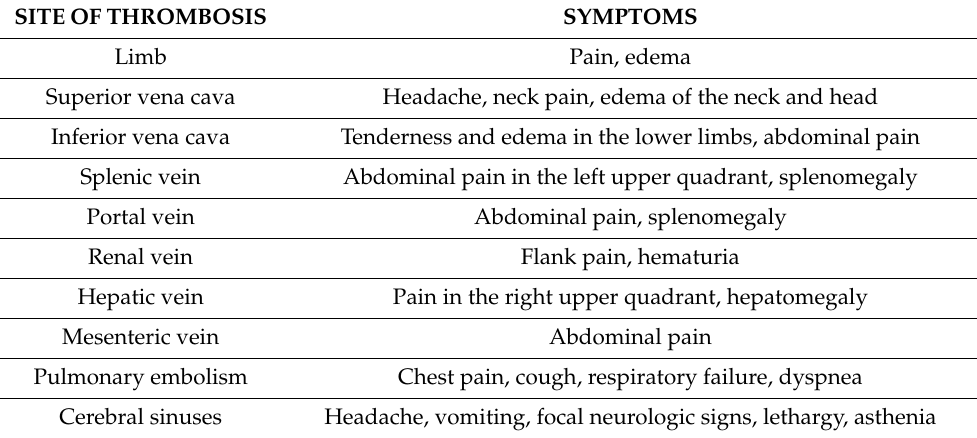
Table 1. Common symptoms of venous thrombosis modified by